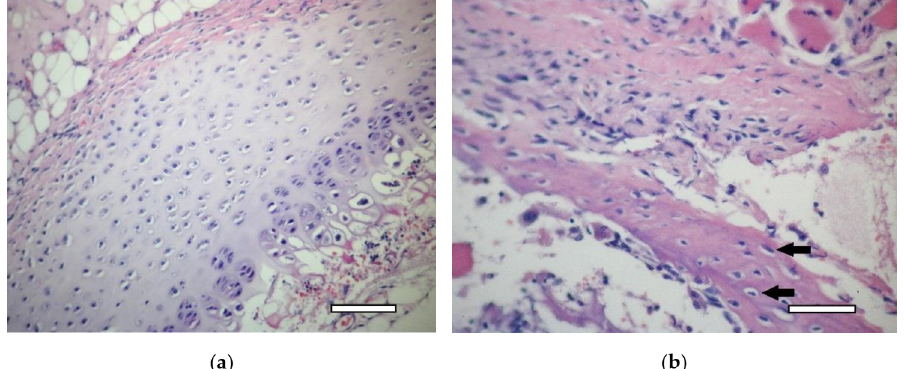
Figure 9. 1st group (dECM only), 1 week. ( a ) cartilage tissue. Staining with hematoxylin and eosin, objective lens × 20, scale bar—100 µ m; ( b ) formation of an osteoid with randomly located osteoblasts (arrows) in muscle tissue near the scaffold. Staining with hematoxylin and eosin, objective lens × 40, scale bar—50 µ